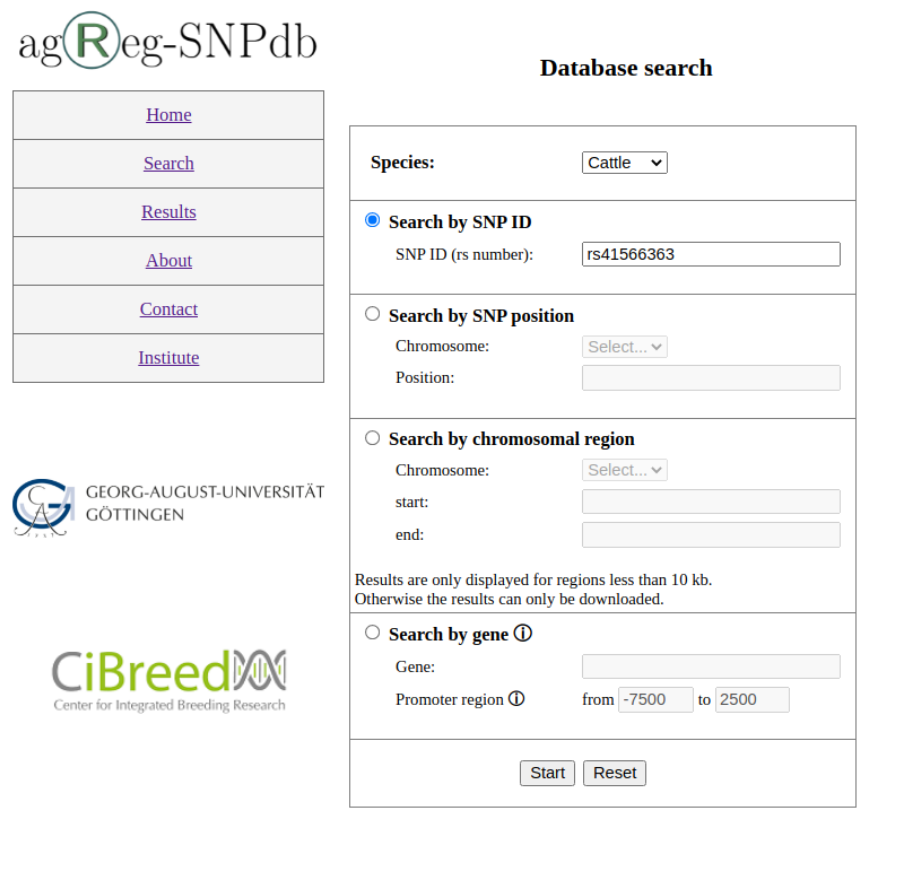
Figure 3. Search page of agReg-SNPdb. Search options are (1) by SNP ID, (2) by SNP position, (3) by chromosomal region, and (4) by